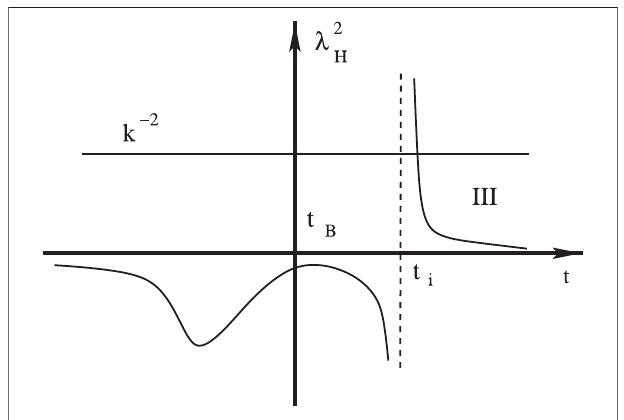
FIGURE 10 | Schematic plot of λ 2 H de fi ned by Eq. 4.10 for the Starobinsky potential and mLQC-II in the hybrid approach, where s ( t i ) (cid:2) 0, and t (cid:2) t i is the starting time of the in fl ationary phase. During the slow-roll in fl ation, we have λ 2 H ≈ L 2 H / 2 (Region III) since the contribution from the potential is in general less than a ’’ / a . Again the qualitative behavior of λ 2 H remains the same as long as the in fl aton starts from the left wing of the potential with a positive velocity and the bounce is initially dominated by the kinetic energy of the in fl aton fi eld.